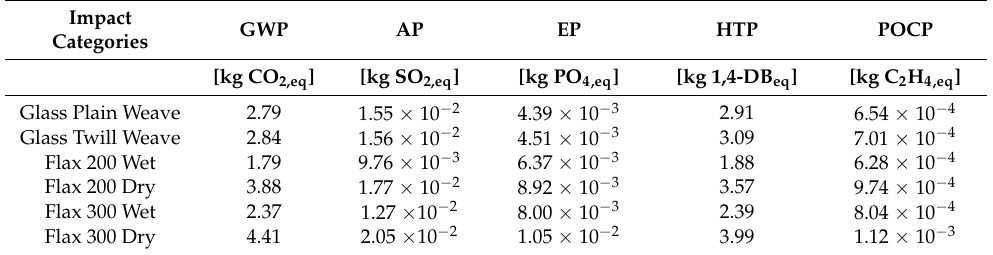
Table 6. Comparison of the total impacts to produce one composite panel per